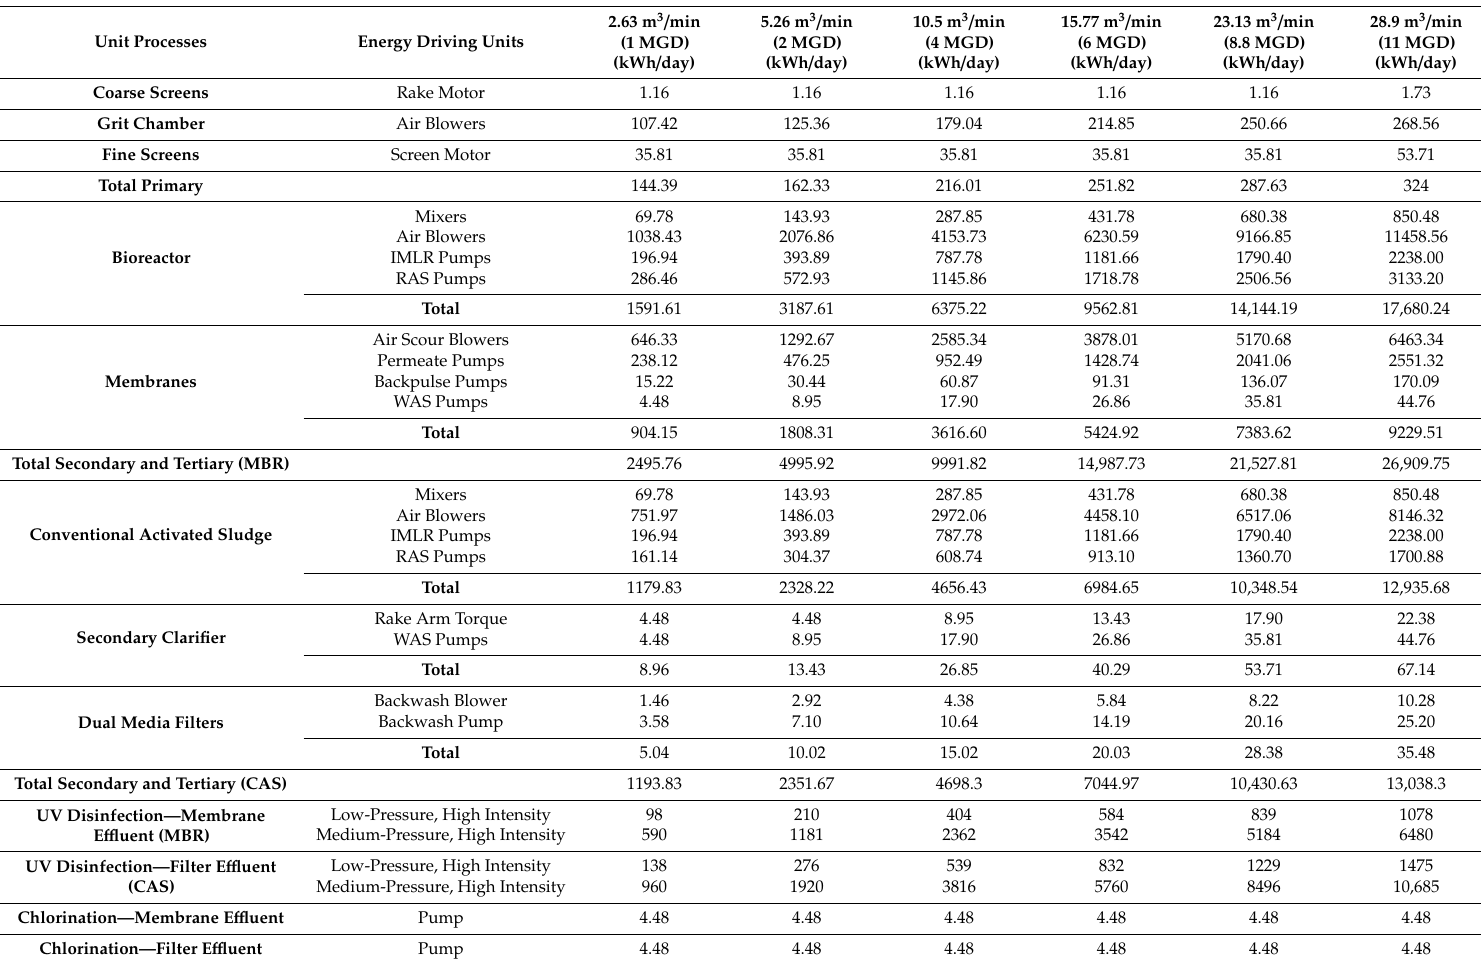
Table 3. Estimated Energy Consumption of Energy Driving Units in Water Reuse Plants of Varying